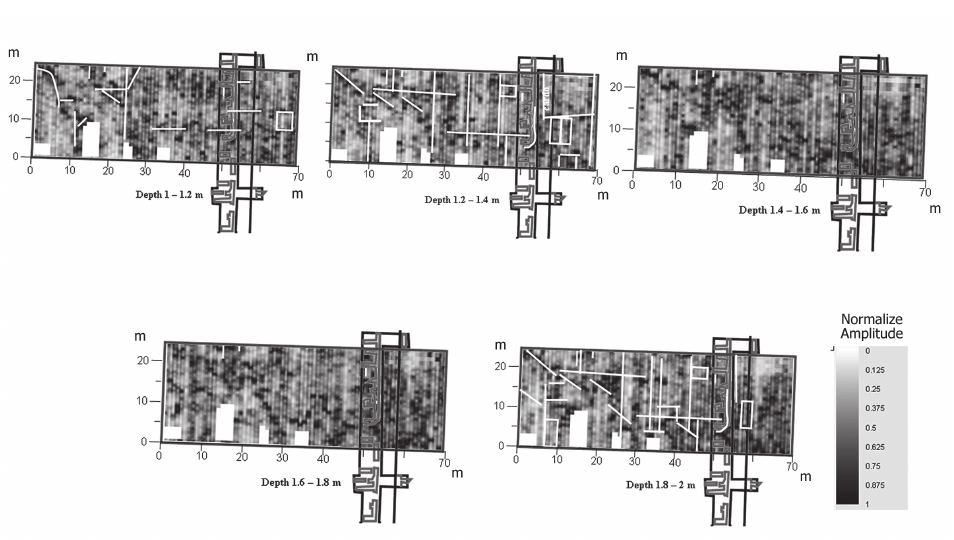
Fig. 5. GPR time-slices referred to a depth ranging from 0.6 to 2.2 m. Time slices were computed along regular grid. Many elongated anomalies cross each other assuming a rectangular shape. These anomalies show a N-S and E-W behavior. Slices referred to a depth ranging from 1.4 – 2.2 m show a NW-SE and SW-NE